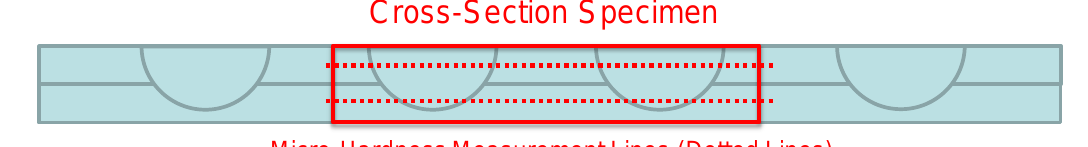
Figure 7. Cross-section specimen and microhardness measurement lines. The microhardness measurement lines are the midplane lines of the top sheet and the bottom sheet.